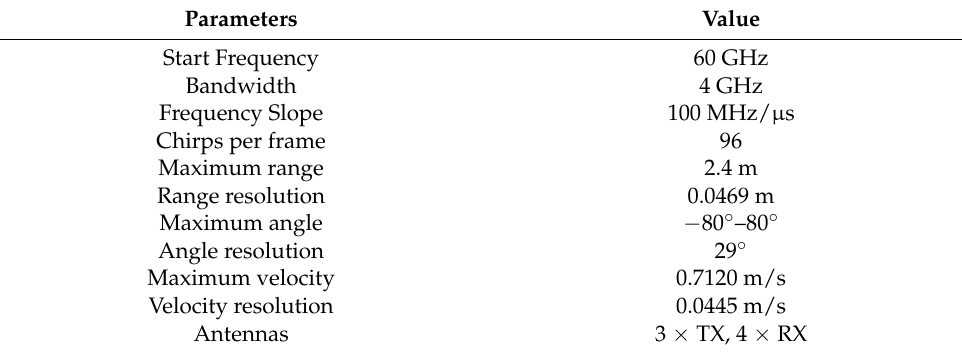
Figure 2. IWR6843AOP appearance diagram. Table 1. The key parameters of the radar.